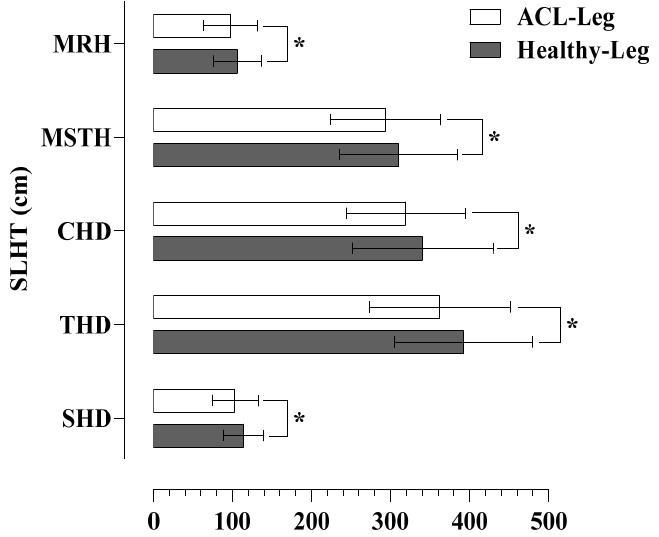
Figure 5. Differences in SLTH distances between operated (ACL-Leg) and healthy leg. * p < 0.05.